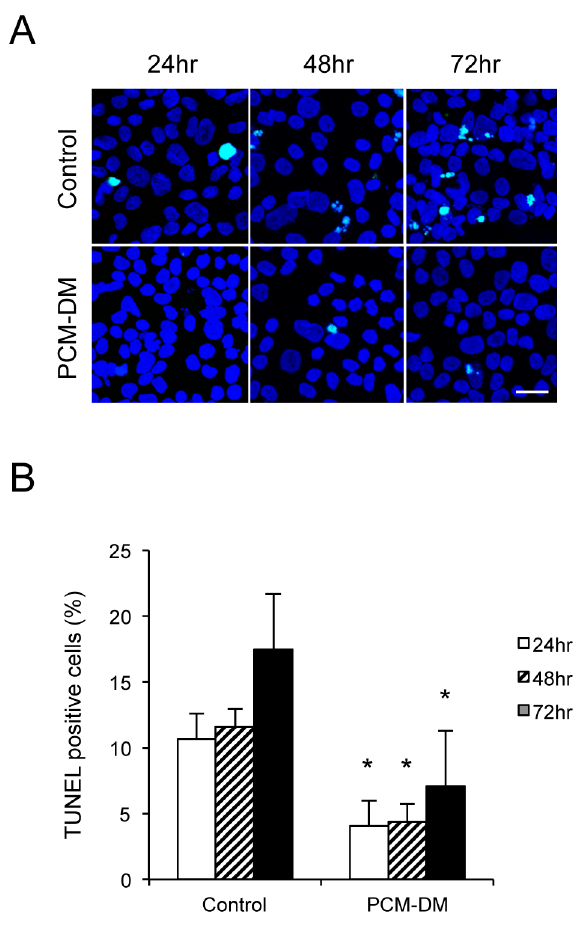
Figure 4. Antiapoptotic effect of PCM-DM . (A) To evaluate the effect of PCM-DM on the apoptosis of MCECs, serum was removed from the culture medium to induce apoptosis. TUNEL staining was performed to evaluate DNA fragmentation during apoptosis after 24, 48, and 72 h. Scale bar: 50 m m. (B) The percentages of TUNEL-positive apoptotic cells were evaluated ( n =3). The experiment was performed in duplicate. * p , 0.01.